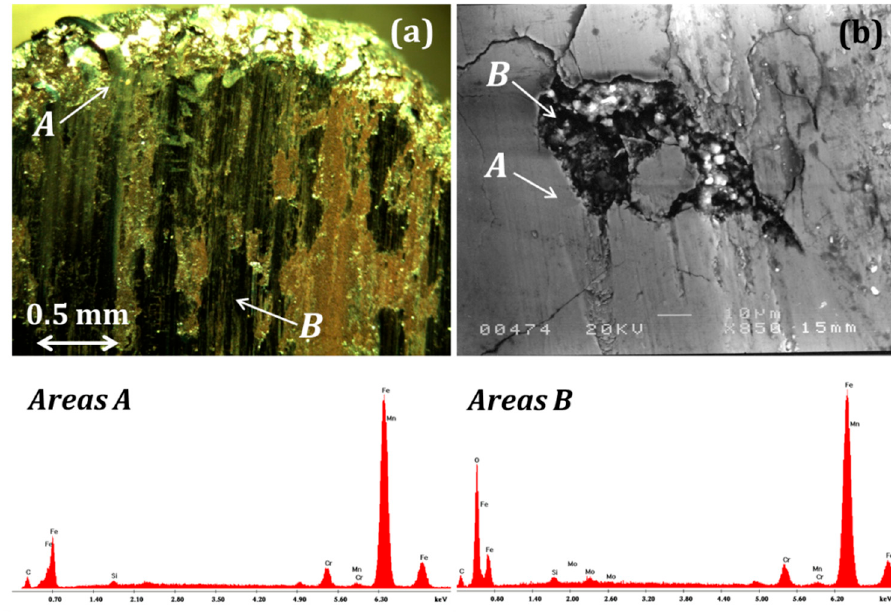
Figure 9. Scanning electron microscopy (SEM) micrographs and EDS point analysis on characteristic areas of the worn surfaces before surface treatment ( a ) and after liquid nitrocarburizing ( b ).